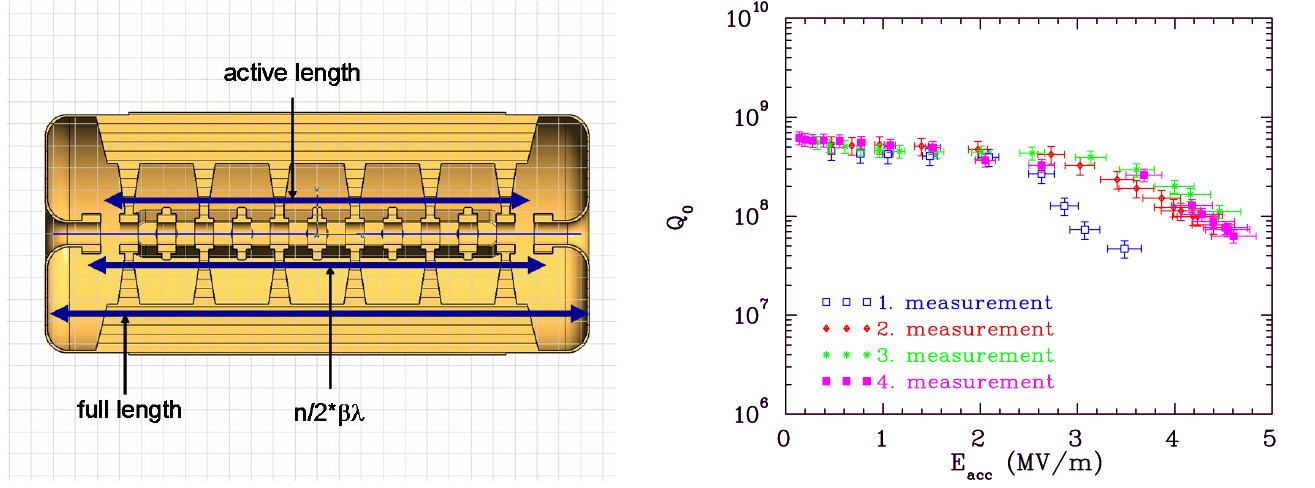
FIG. 31. (Color) Commonly used length definitions in a cavity and their illustration with respect to CH